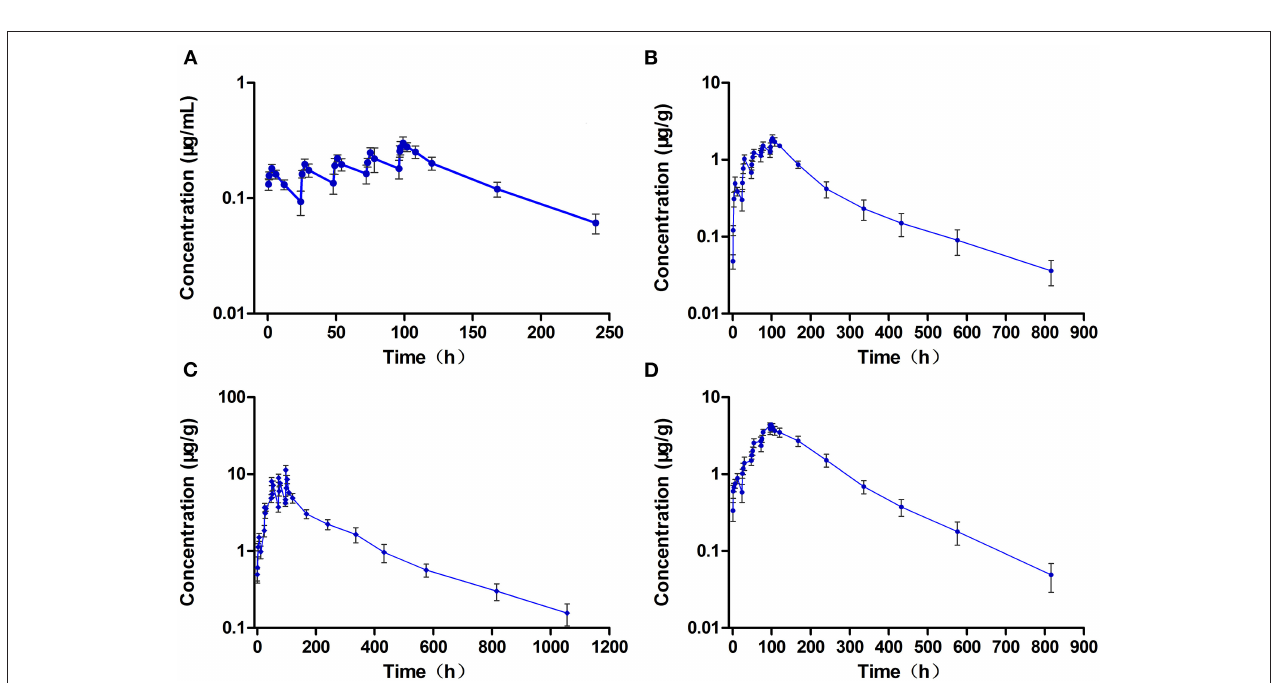
FIGURE 5 | The concentration vs. time curves of ciprofloxacin in the plasma (A) , muscle/skin (B) , liver (C) , and kidney (D) of crucian carp during and after multiple oral doses of enrofloxacin (20 mg/kg b.w. daily for 5 days) at 28 ◦ C ( n = 6).